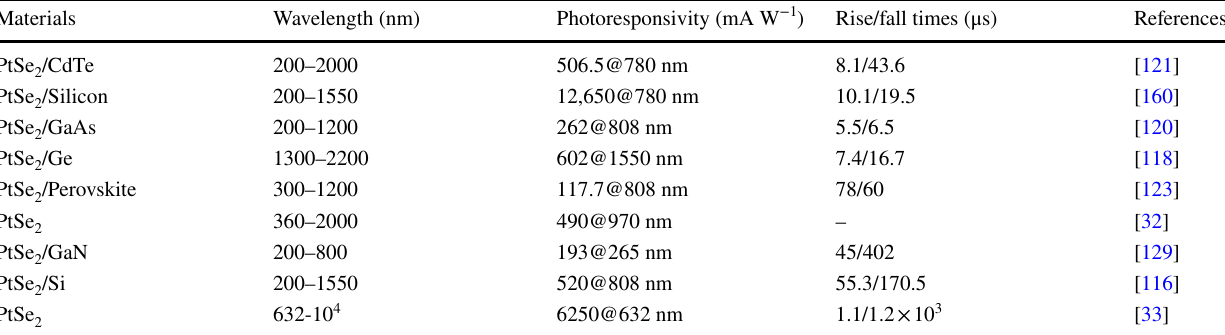
Table 2 Summary of PtSe 2 ‑based photodetectors